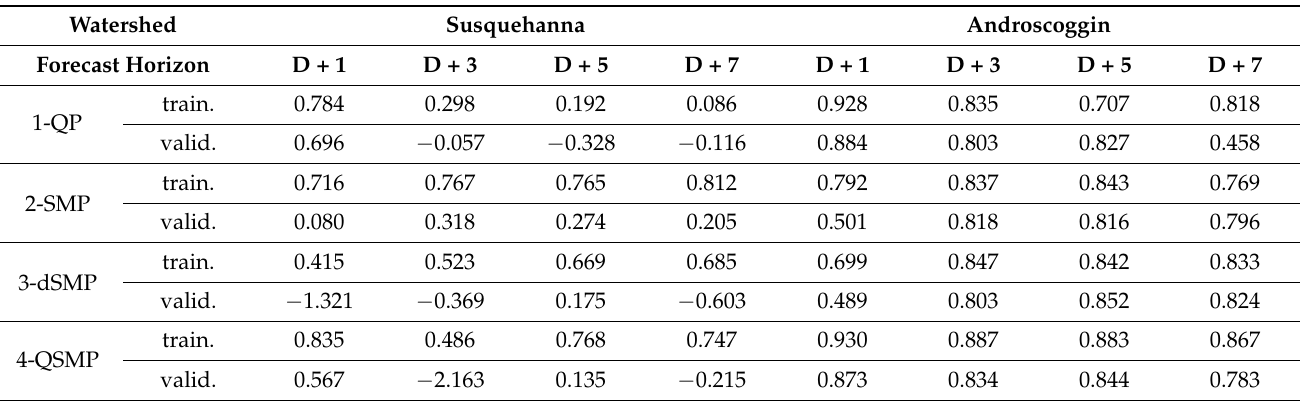
Table 5. Nash–Sutcliffe efficiency (NSE) values for Susquehanna and Androscoggin for summer 2009, a relatively wet year, as validation period.